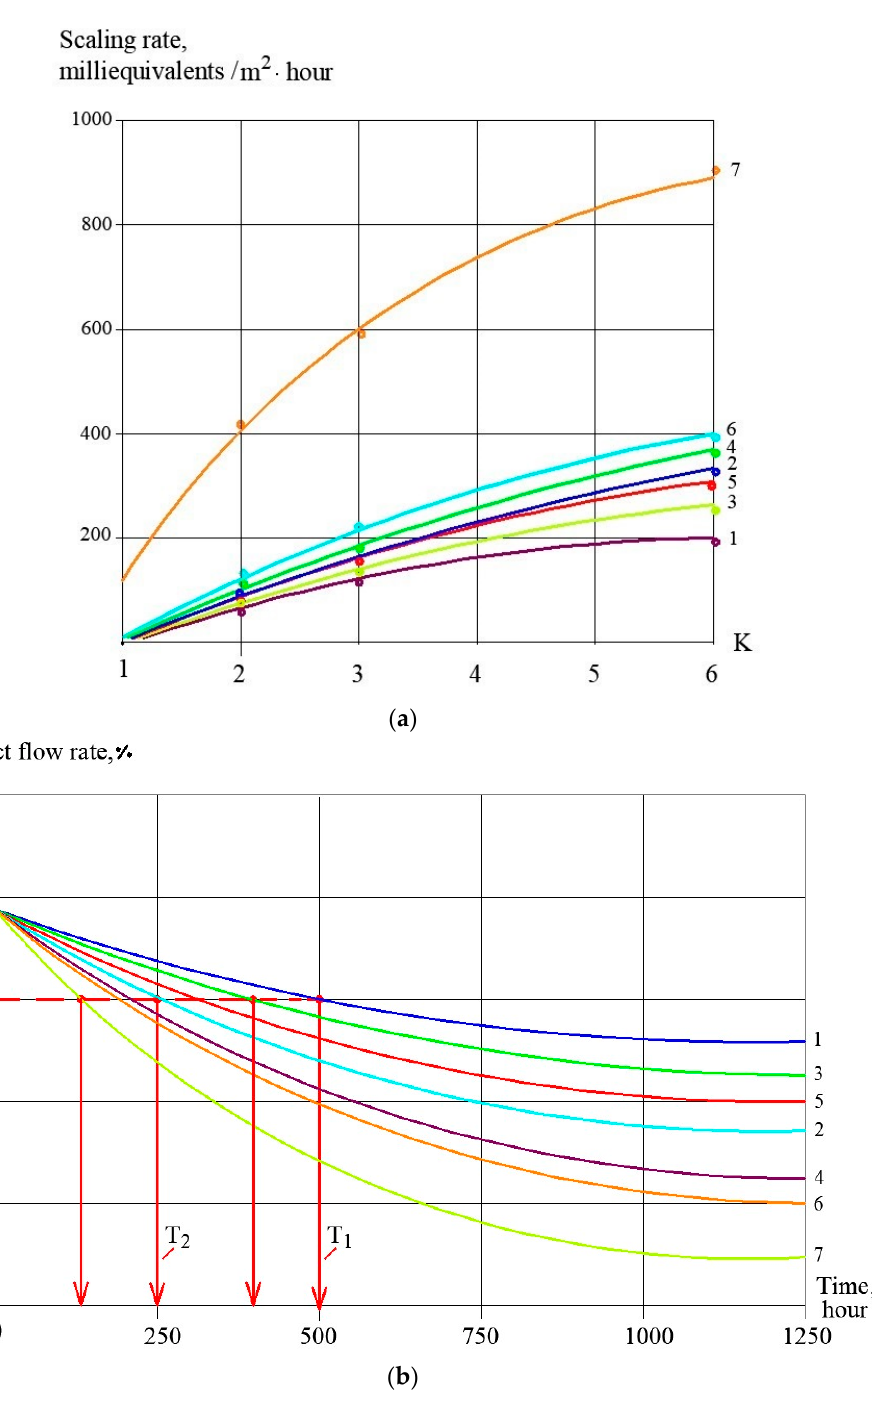
Figure 7. Prediction of membrane product flow decrease with calcium carbonate accumulation over time and recommended time between membrane cleanings: ( a )—dependencies of accumulated calcium carbonate amount on time; ( b ) dependencies of product flow on time; 1—water composition 1, Aminat K 5; 2—water composition 1, Jurby Soft 5 ppm; 3—water composition 2, Aminat K 5; 4—water composition 2, Jurby Soft 5 ; 5—water composition 3, Aminat K 5; 6—water composition 3, Jurby Soft 5 ppm; 7—water composition 1, without antiscalant addition (Table 1).